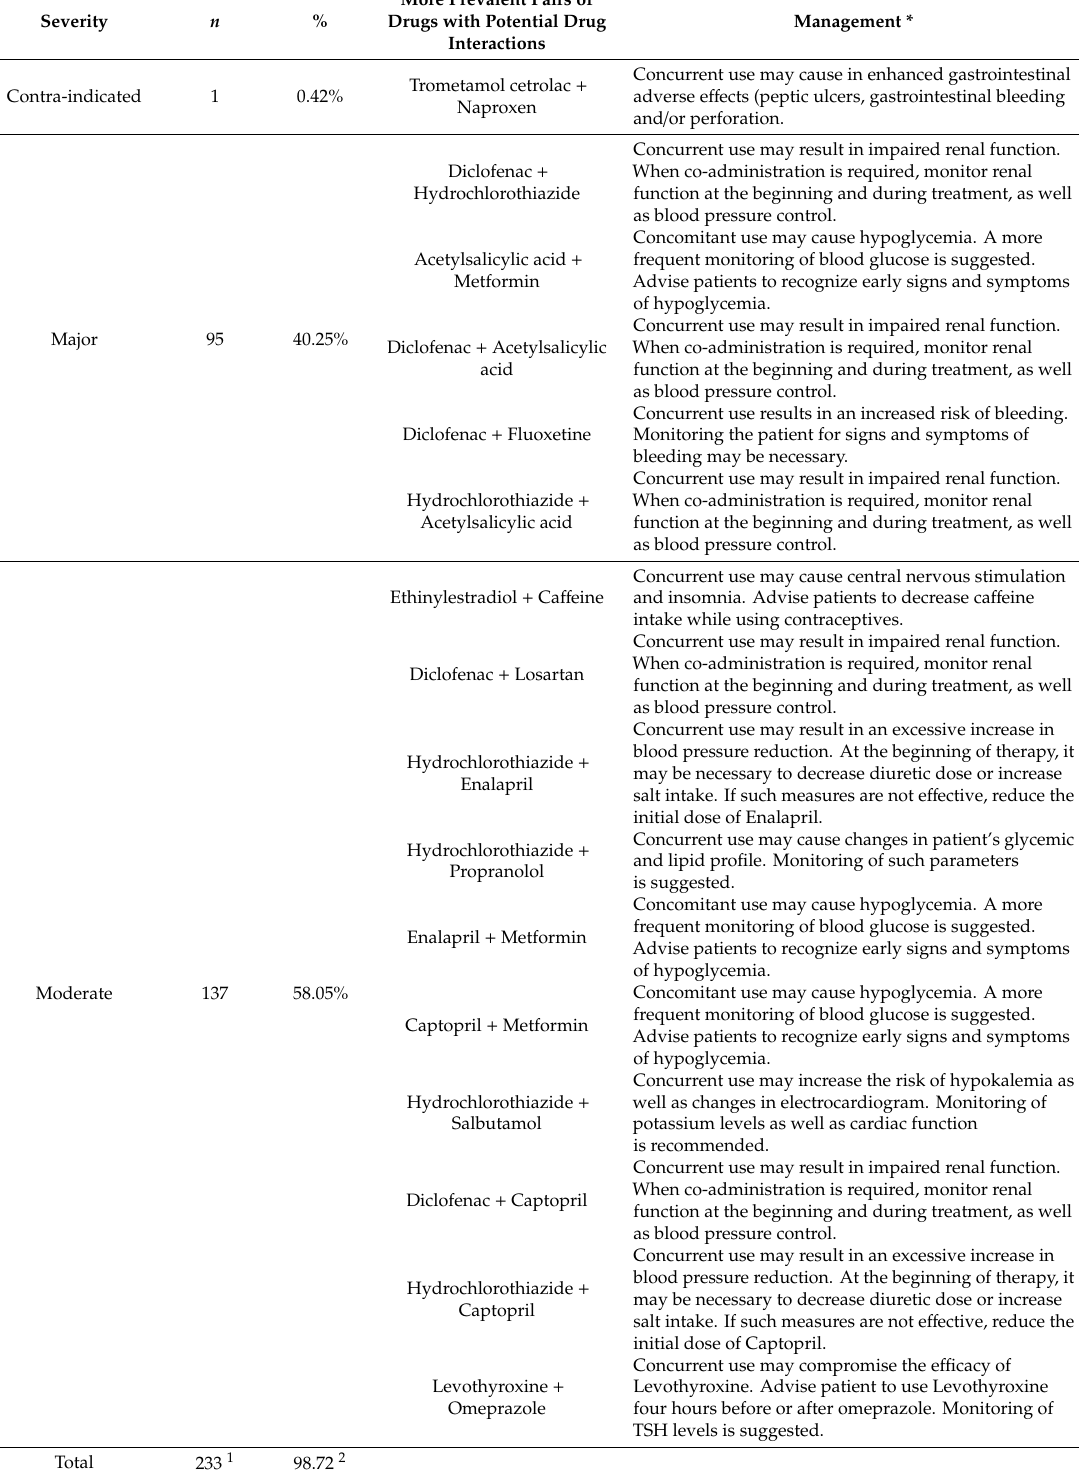
Table 1. Potential drug interactions more prevalent in adults with severe obesity according to severity and clinical